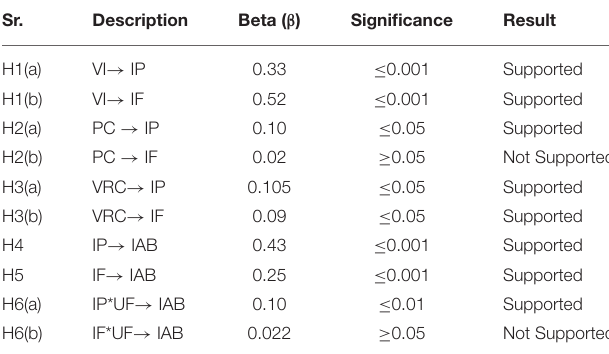
TABLE 4 | Parameter estimation for proposed model.